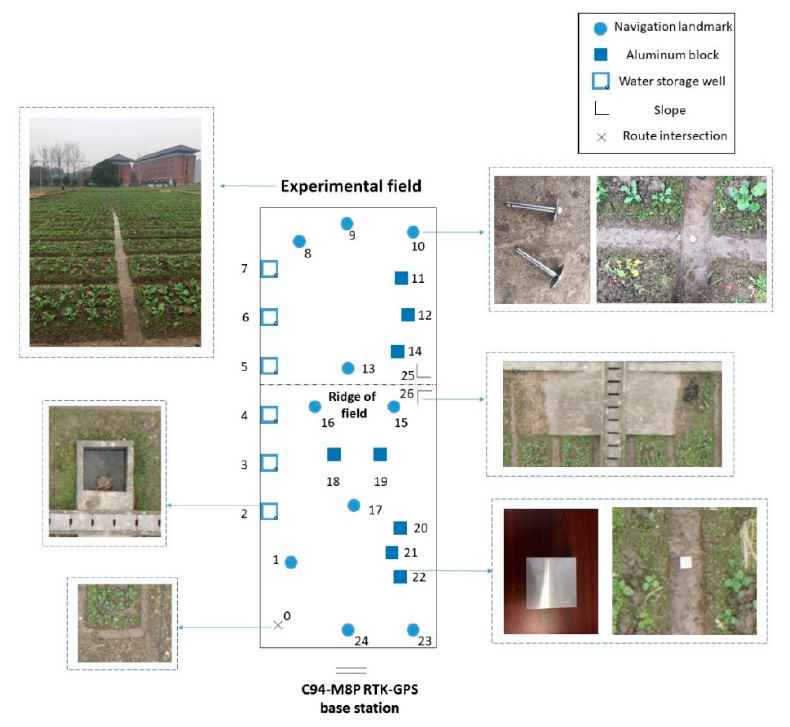
Figure 2. Diagram of experimental environment.